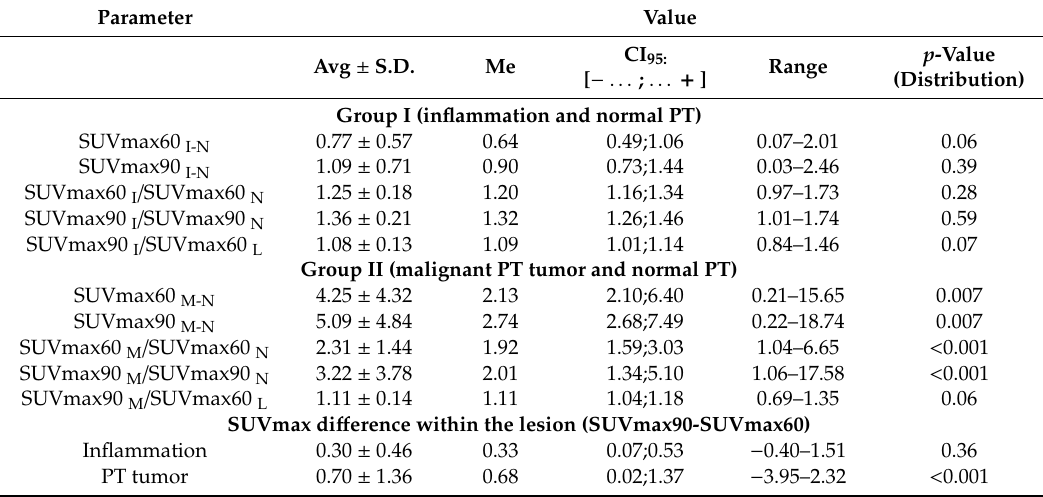
Table 5. Normal and abnormal PT comparison: di ff erences and